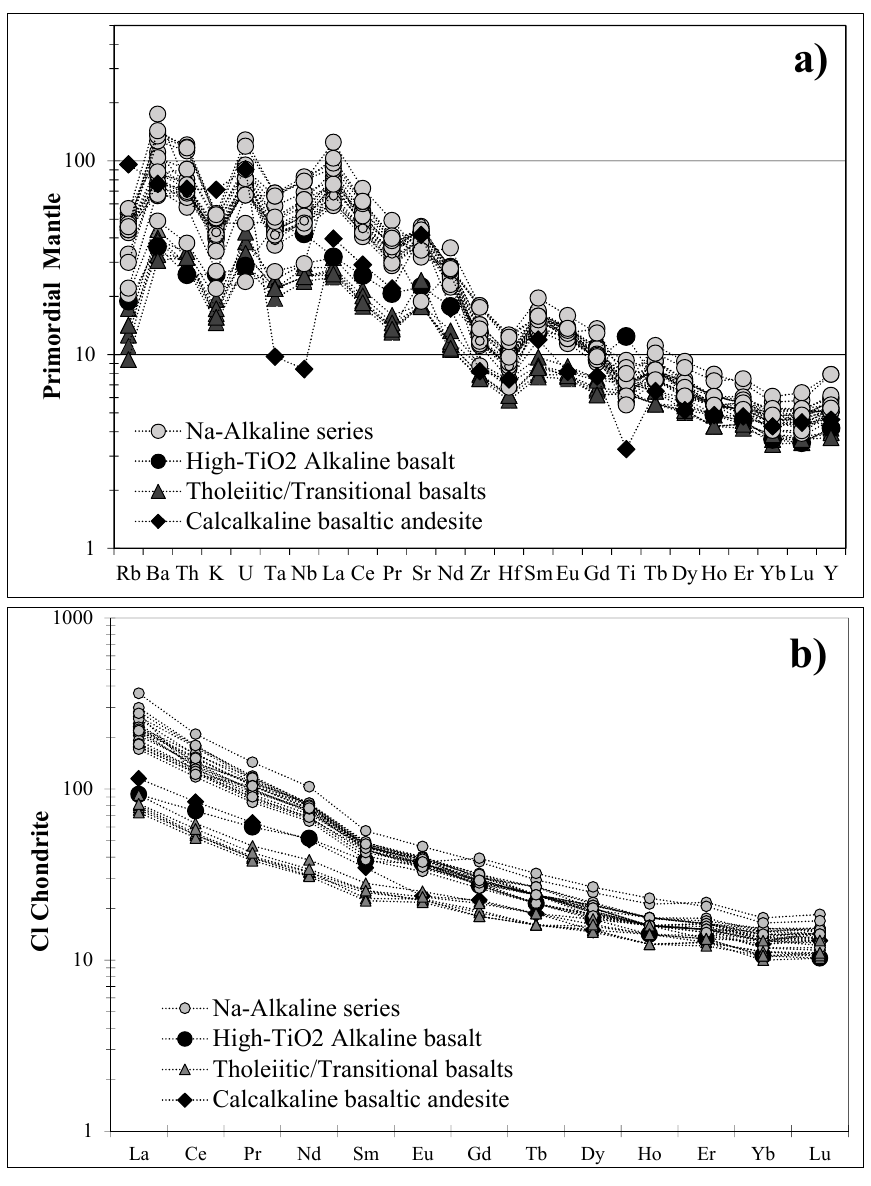
Figure 6. Incompatible trace elements ( a ) and rare earth elements ( b ) diagrams of the investigated millstones normalized to the primordial mantle ( a ) and CI Chondrites ( b ). Normalized values are from [54].